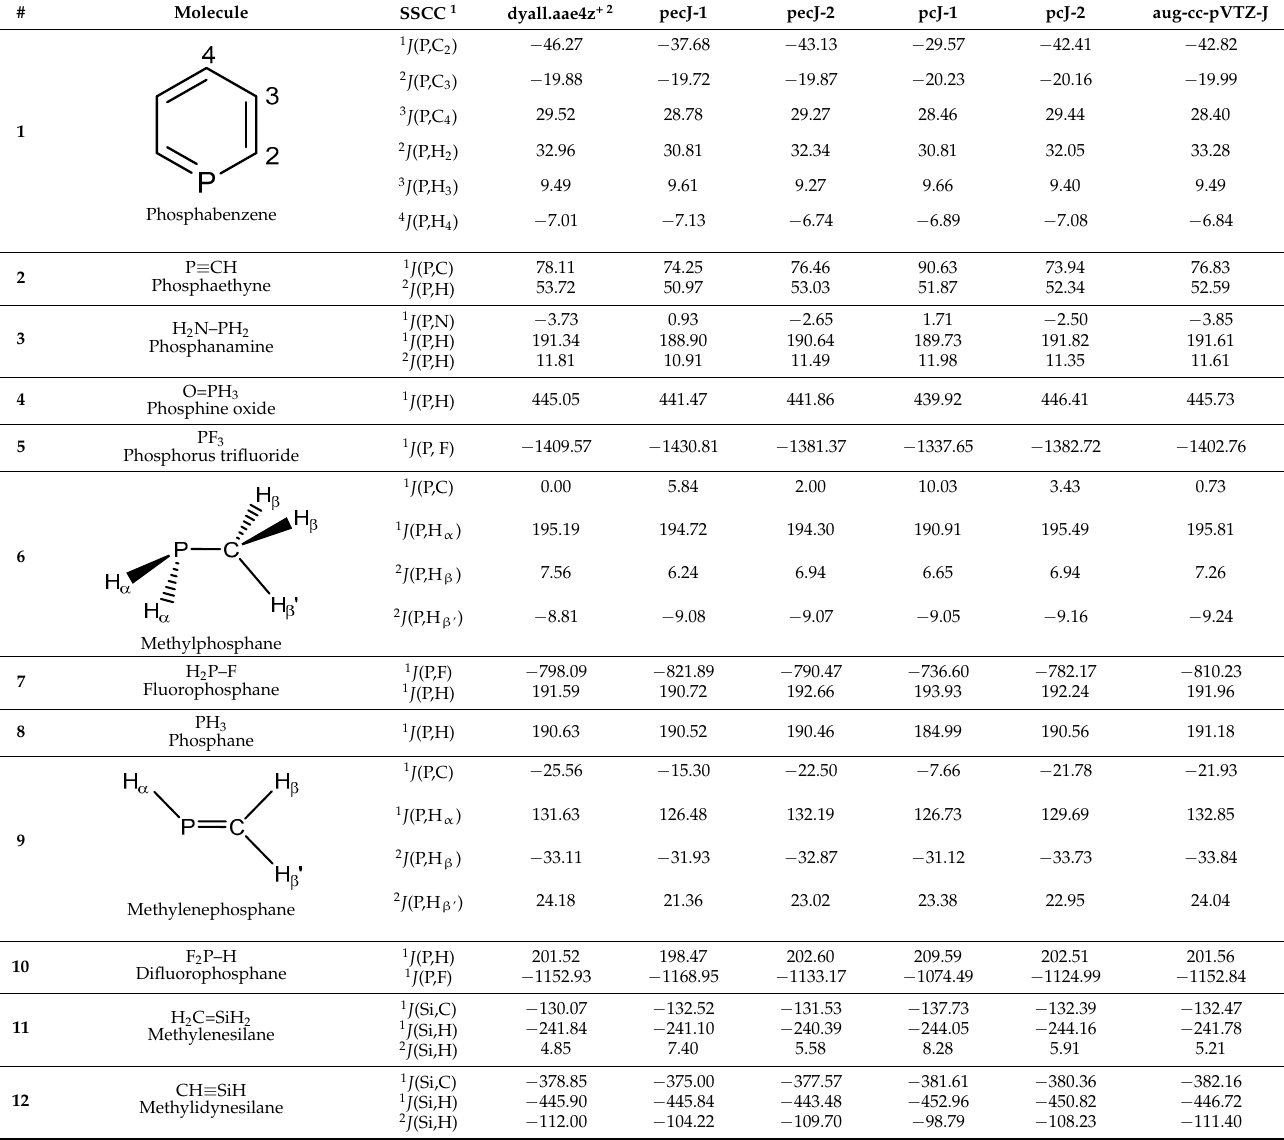
Table 3. SSCCs (in Hz) calculated at the SOPPA(CCSD) level with dyall.aae4z + , pecJ- n ( n = 1, 2), pcJ- n ( n = 1, 2), and aug-cc-pVTZ-J basis sets.